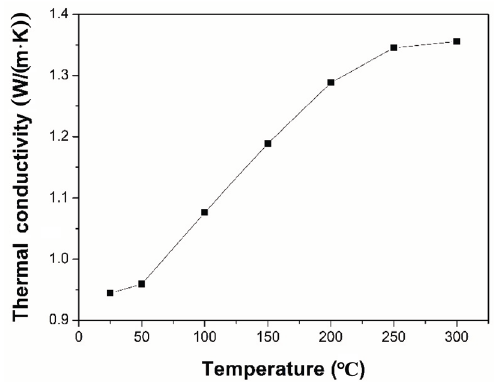
Fig. 15 Temperature dependence of thermal conductivity of the closed cell ZrC/C foams prepared by foaming methods [23]. Reproduced with permission from Ref. [23], © Elsevier Ltd.